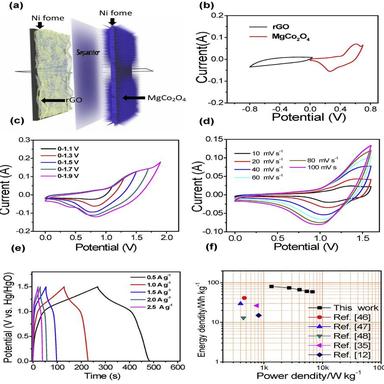
Electrochemical performance of the MgCo2O4//rGO asymmetric supercapacitor (ASC) device. (a) Structural illustration of the ASC: the MgCo2O4 as the positive electrode and rGO as the negative electrode. (b) CV curves of the negative electrodes and the positive electrodes at a scan rate 50 mV s1 . (c) CV curves of the MgCo2O4//rGO at different scan voltage windows at a same scan rate of 100 mV s1 . (d) CV curves of the MgCo2O4//rGO at different scan rate range from 10 to 100 mV s1 . (e) GCD curves of the MgCo2